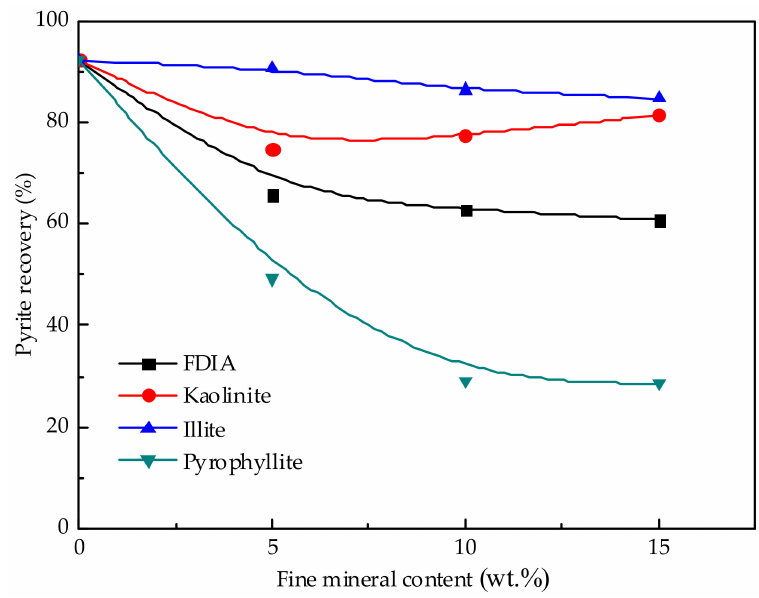
Figure 9. E ff ect of di ff erent fine mineral additions on pyrite